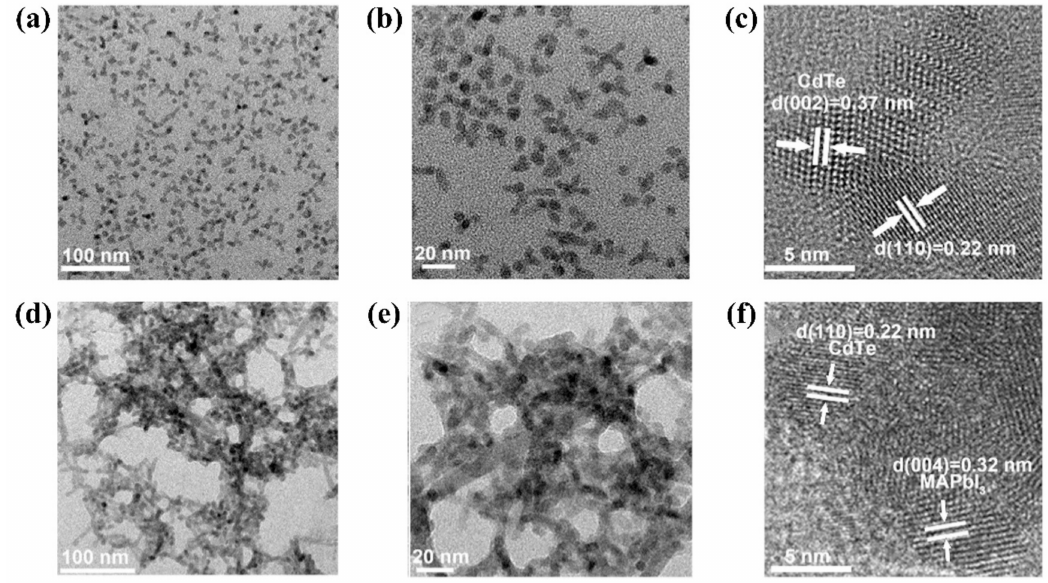
Figure 7. ( a ) The TEM, HRTEM images of the CdTe QDs before ( a – c ) and after ( d – f ) ligand exchange. Reproduced from [120], with permission from Elsevier,